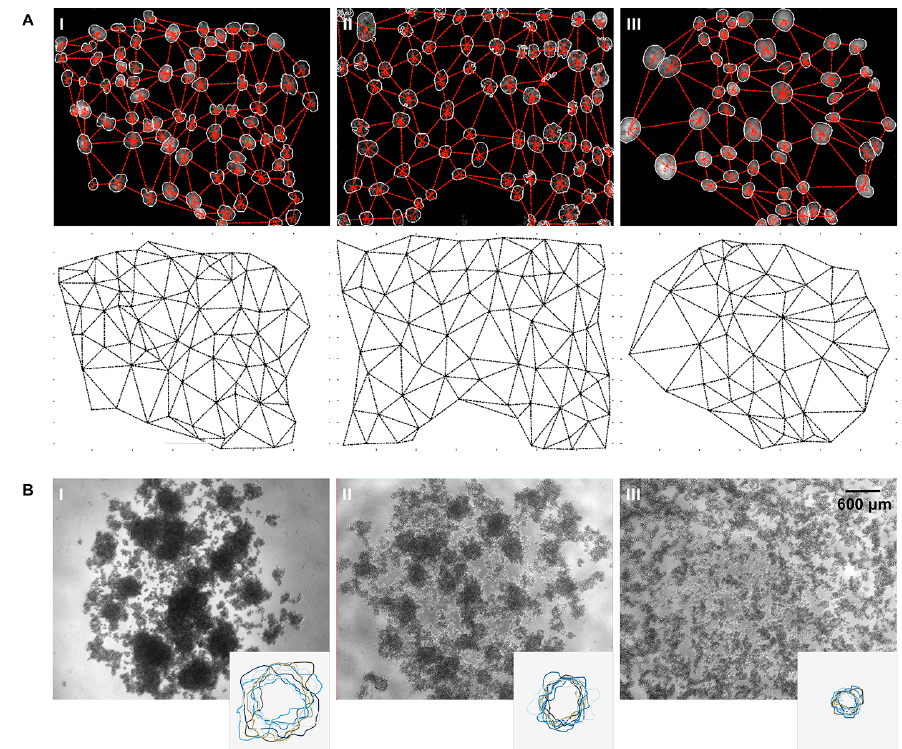
Figure 3. Intercellular organization and cell adhesive properties induced by CDH1 germline missense variants. ( A ) Patterns of cellular distribution elicited by E-cadherin variants. In the upper panel, cell nuclei are overlapped with the corresponding network. In the lower panel, the final networks are presented. ( AI ) Illustrates a more regular and cohesive cellular topology, while ( AII ) depicts an intermediate cellular organization, and ( AIII ) represents a scatter and disorganized phenotype. ( B ) Adhesiveness of cells expressing E-cadherin variants evaluated by slow-aggregation assays and corresponding outlines of cellular aggregates. Variants preserving a functional adhesion complex display compact cellular aggregates ( BI ), while dysfunctional E-cadherin forms present small cellular aggregates ( BII ) or an isolated phenotype ( BIII ). The images illustrate different adhesiveness effects on E-cadherin missense variants cells as firstly described in [40,46].